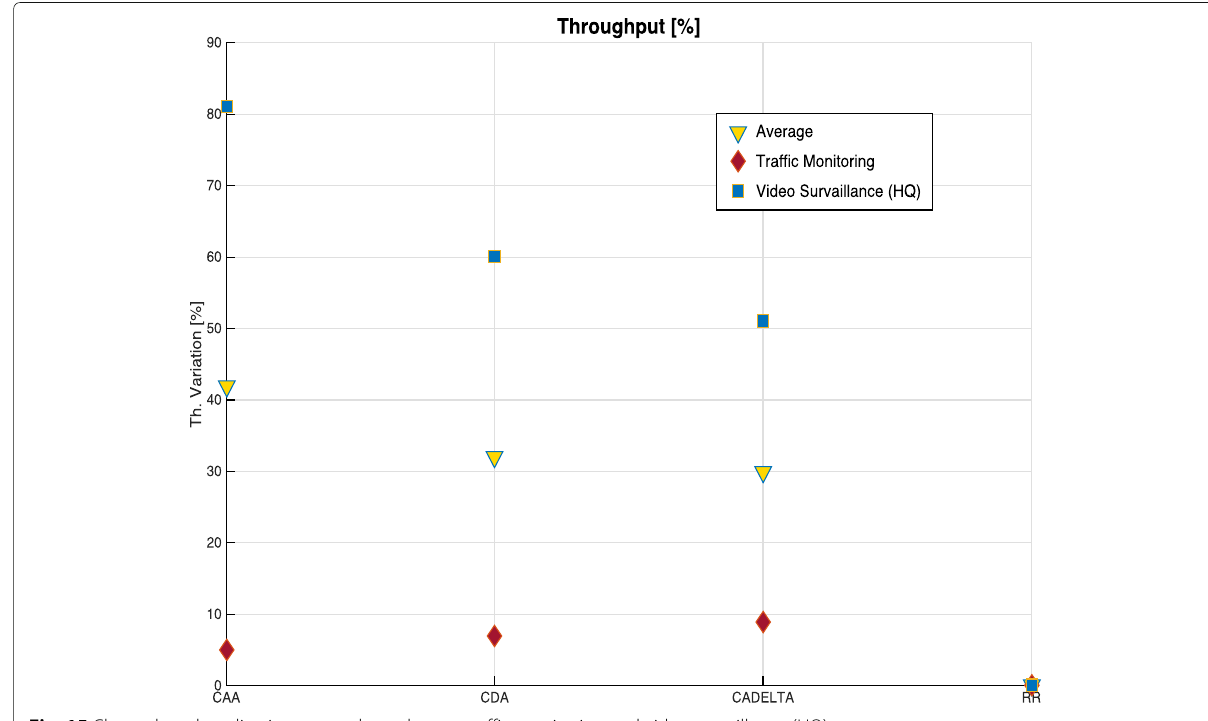
Fig. 15 Channel- and application-aware throughput—traffic monitoring and video surveillance (HQ)